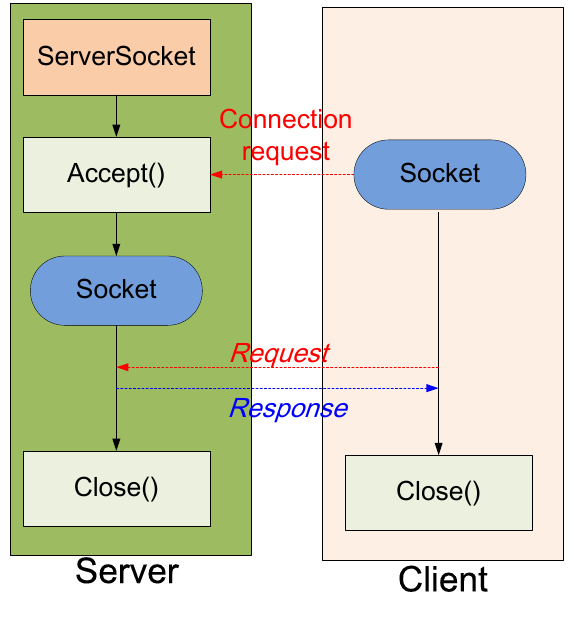
Figure 6. Connection between server and